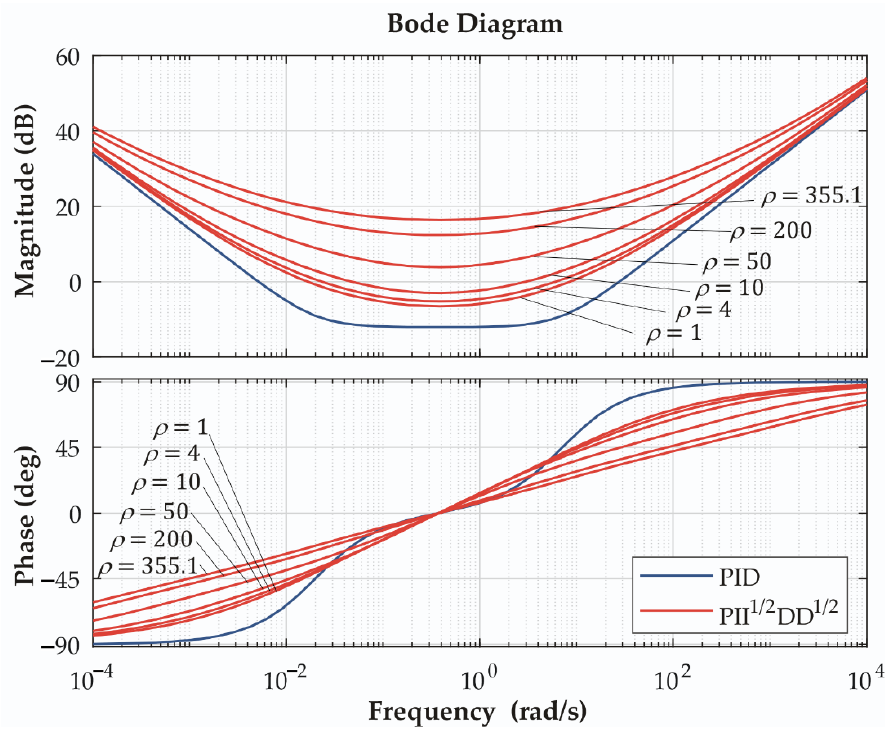
Figure 8. Influence of the ratio ρ of the controller Bode plots: PID (blue) and PII 1/2 DD 1/2 H (red), for ρ = 1, 4, 10, 50, 200, ρ max = 355.1.